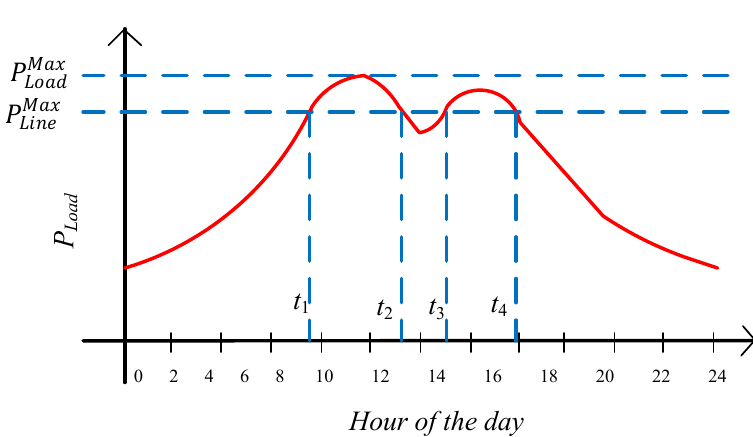
Figure 1. Load curve, and capacity of